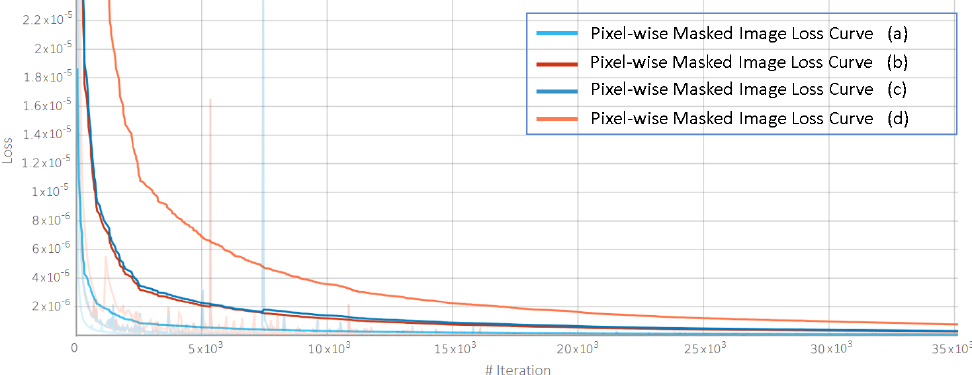
Figure 10. Loss curves for pixel-wise missing data